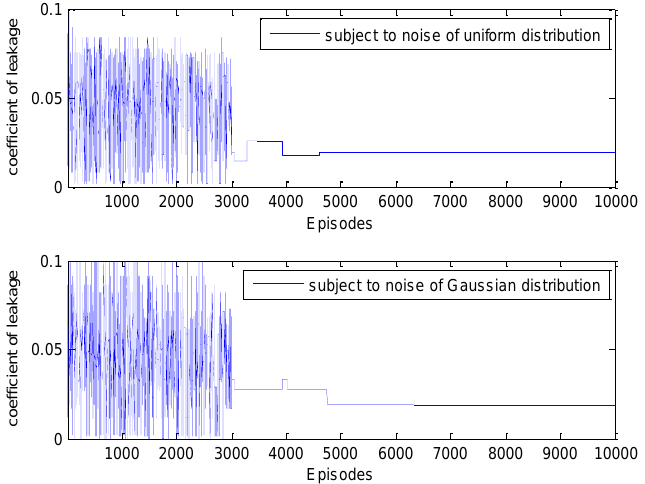
Figure 12. The episode training process of leakage coefficient ( λ c was predetermined as 0.02). The values of leakage coefficient 𝜆̂ 𝑐 are acquired when the curve becomes stable.